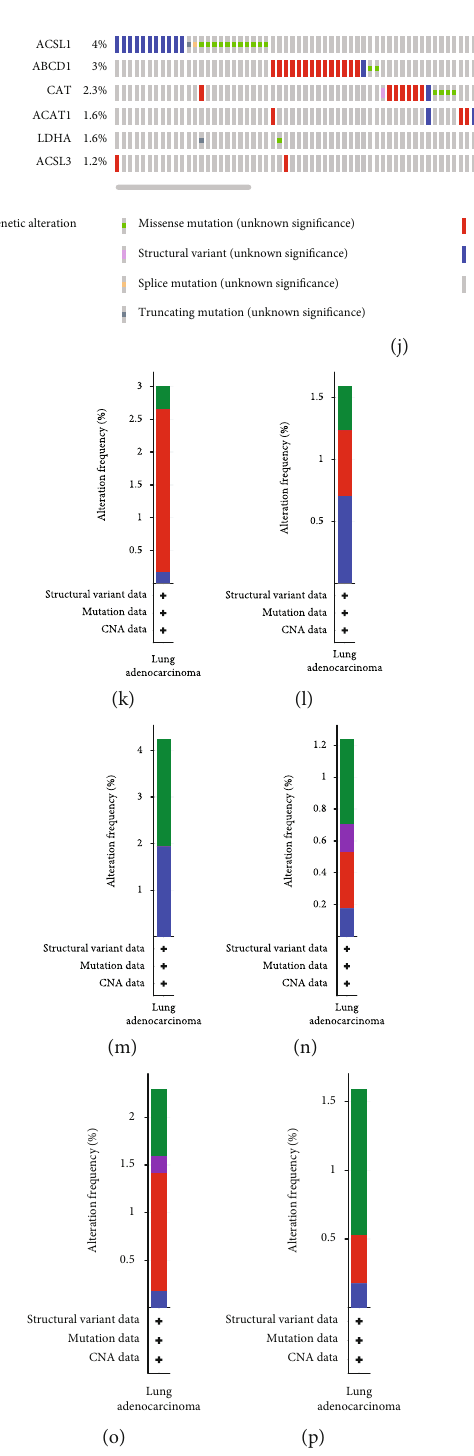
Figure 5: Analyses of ferroptosis, cancer stem cell in fi ltration, and TMB in two risk groups. (k – p) Mutation type and mutation rate of signature genes. (a) Expression of ACSL4 in two groups. (b) Expression of CHAC1 in two groups. (C) Expression of PTGS2 in two groups. (d) Expression of TFRC in two groups. (e) Measuring of cancer stem cell in fi ltration at RNA level. (f) Measuring of cancer stem cell in fi ltration at DNA level. (g) TMB of two groups. (h) Gene mutation in high-risk group. (i) Gene mutation in low-risk group. (j) Summary of mutations of six signature genes. (k) ABCD1. (l) ACAT1. (m) ACSL1. (n) ACSL3. (o) CAT. (p)